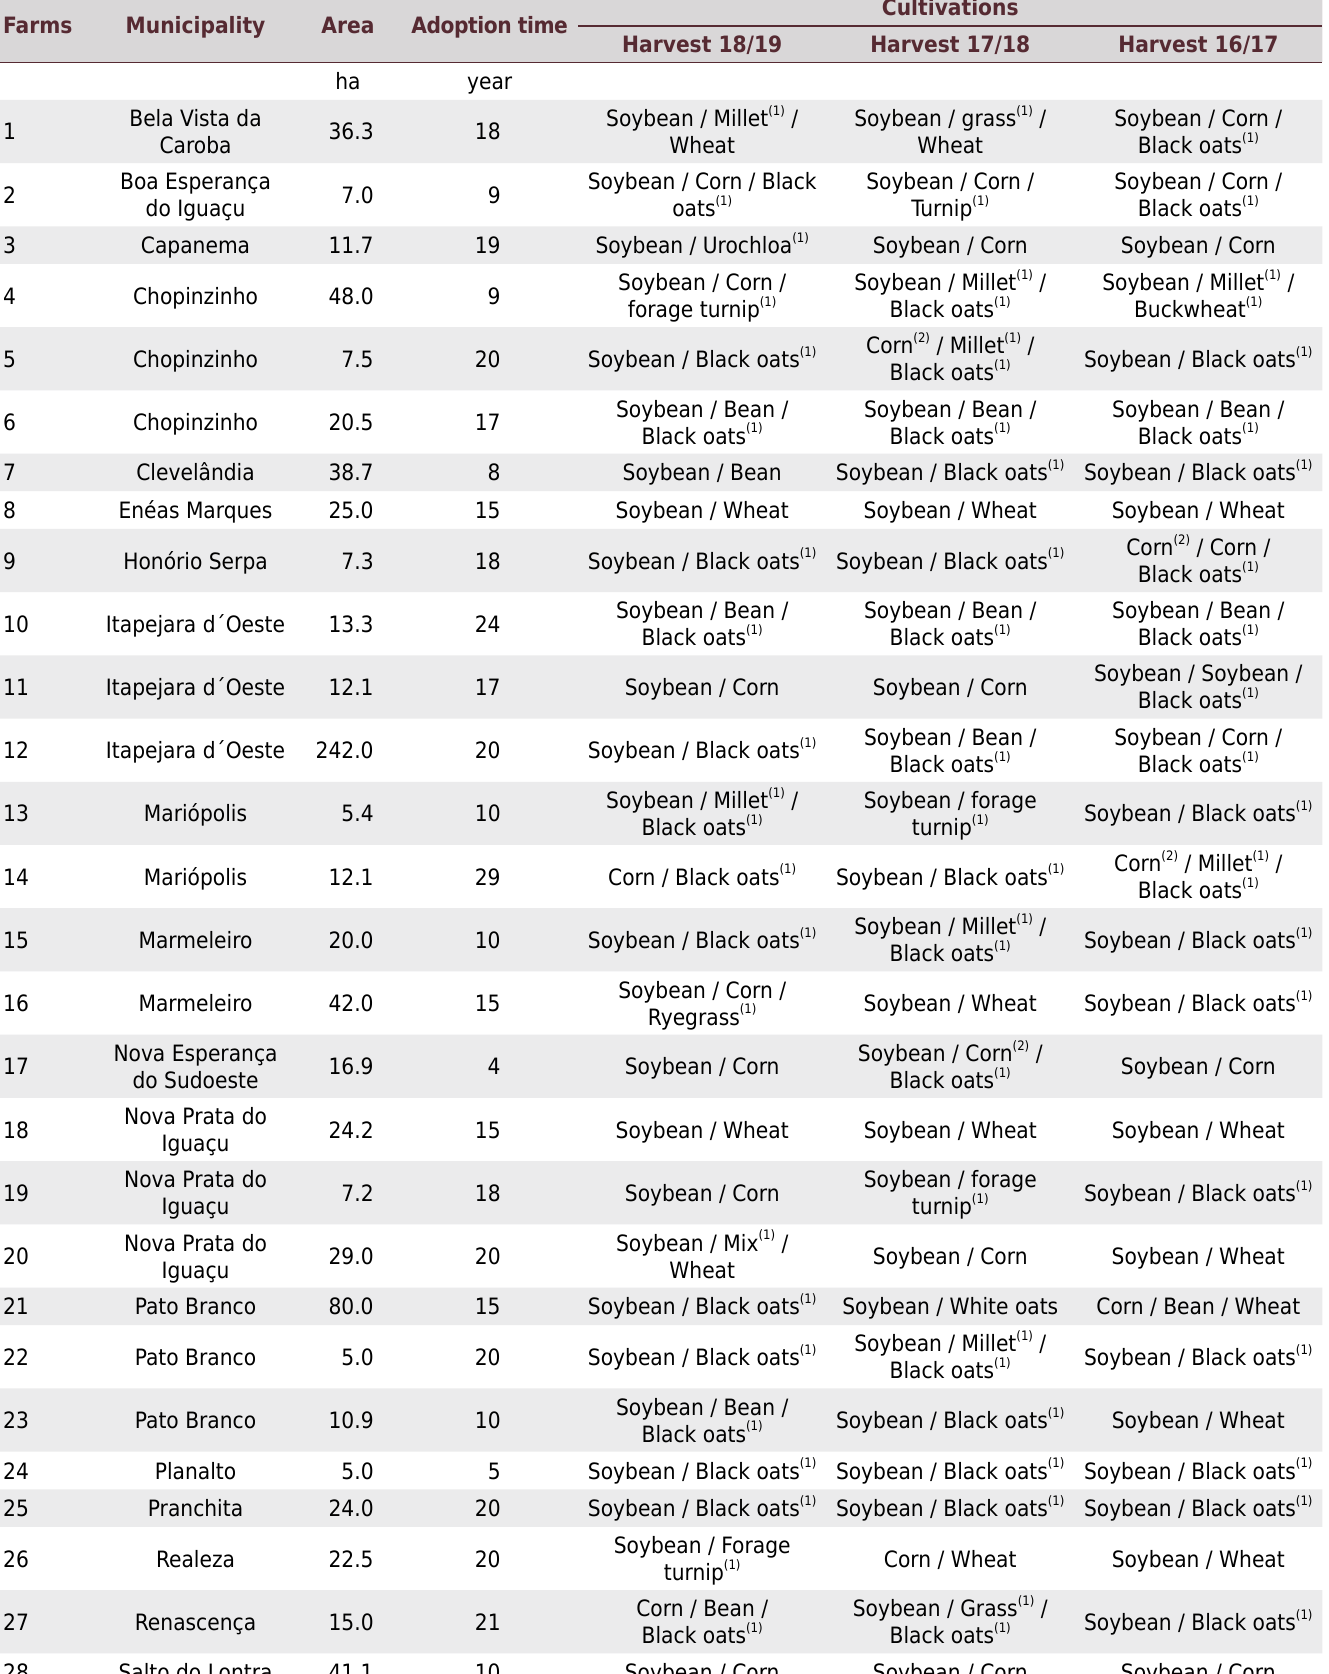
Table 3. General characterization of the farms, municipalities, total area of annual crops, time of no-tillage adoption, and cultivations of the last three years in southwestern Paraná Farms Municipality